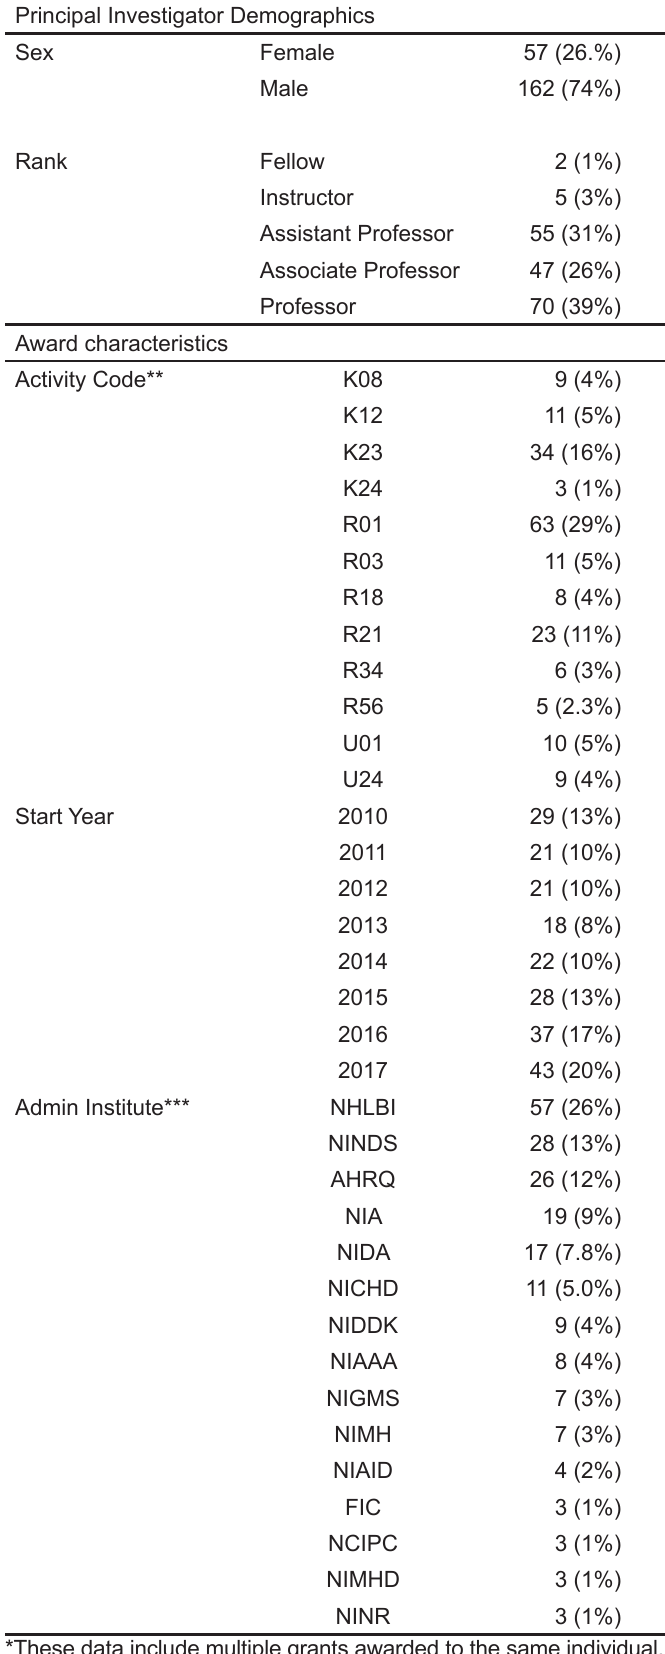
Table 1. Grant characteristics from NIH RePORTER